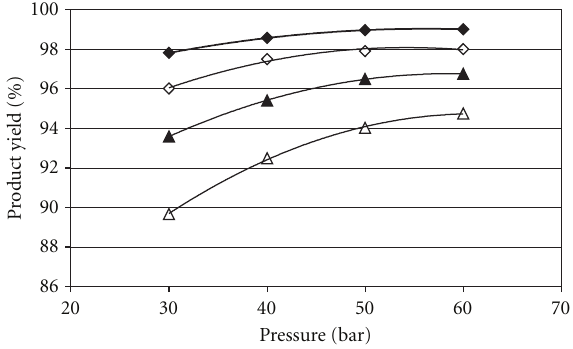
Figure 10: Product yields as a function of temperature and pressure; where -320 ◦ C, -340 ◦ C, -360 ◦ C and Δ -380 ◦ C (LHSV (cid:4) (cid:5) (cid:3) = 1.0h − 1 , H = 400Nm 3 /m 3 ). 2 / hydrocarbon volume ratio